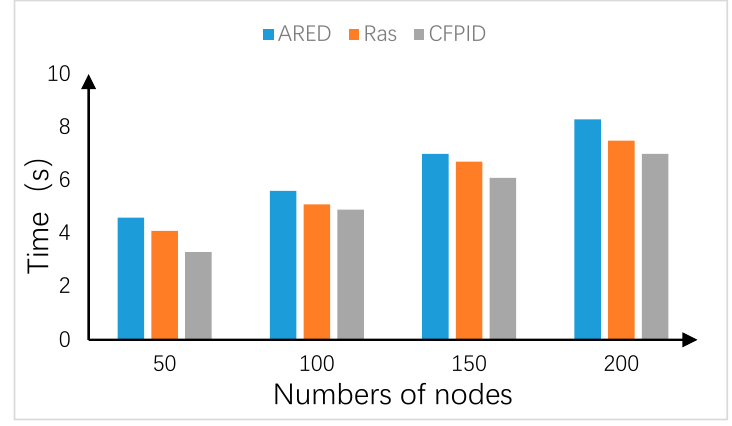
Figure 12. Running time comparison.